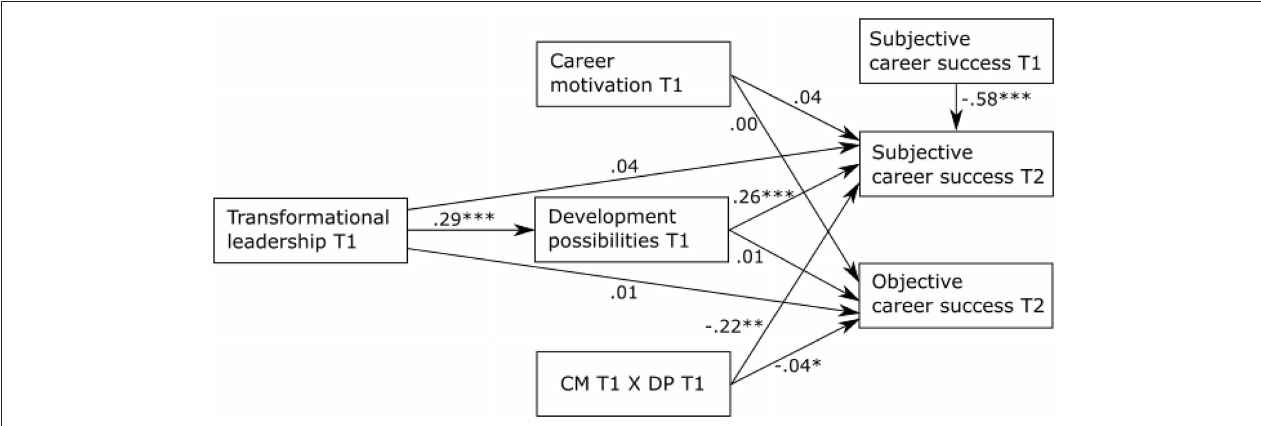
FIGURE 1 | The conditional indirect effect model. CM, career motivation; DP, development possibilities; T1, time point 1; T2, time point 2. The values are standardized regression coefficients. * p < 0.05; ** p < 0.01; *** p < 0.001.